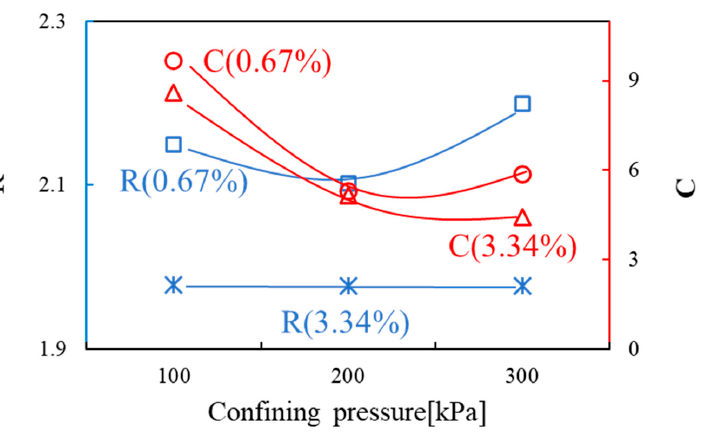
Figure 10. Ramberg-Osgood model parameters R and C versus confining pressure, for sand mixed with various concentrations of sodium alginate solution.